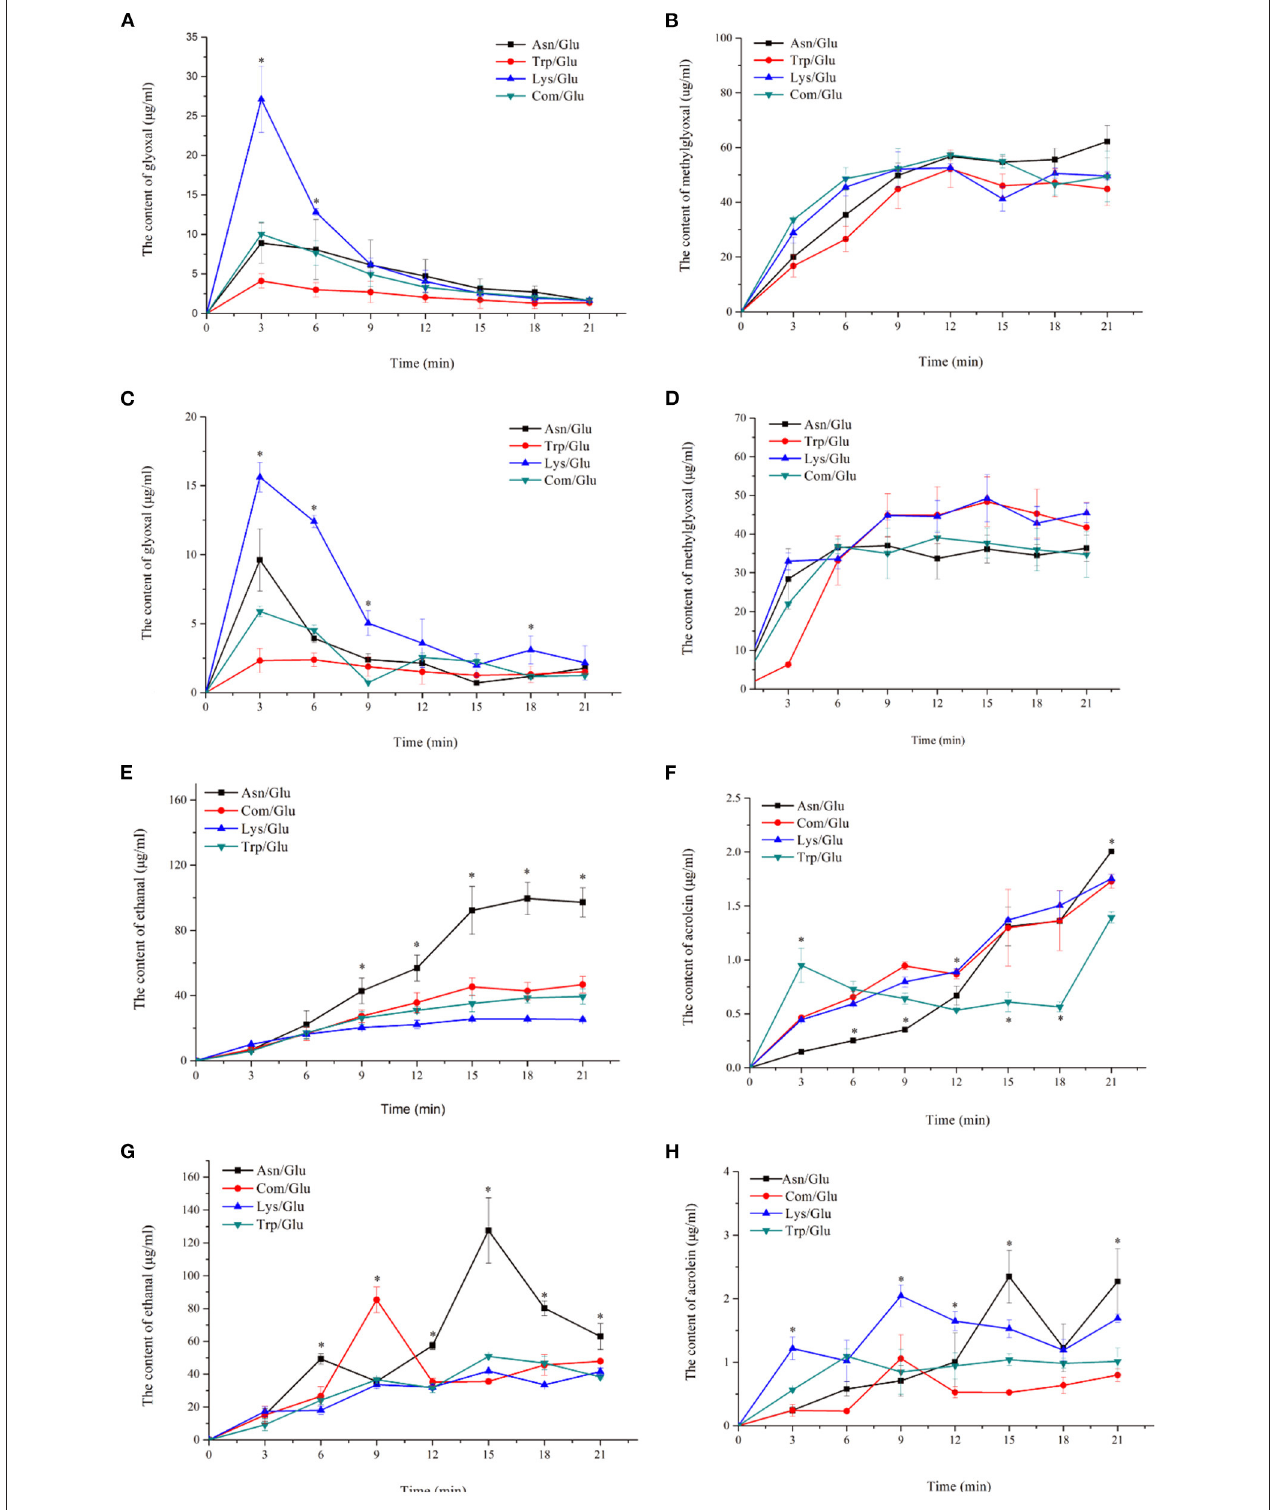
FIGURE 3 | Kinetic profiles of major ketone and aldehyde intermediate compounds: glyoxal (A,B) , methylglyoxal (C,D) , acetaldehyde (E,F) and acrolein (G,H) in the different amino acid/glucose model system heated at 170 ◦ C (A,C,E,G) and 200 ◦ C (B,D,F,H) . Data were expressed as mean ± SD in triplicates ( n = 3), *, ( P < 0.05).